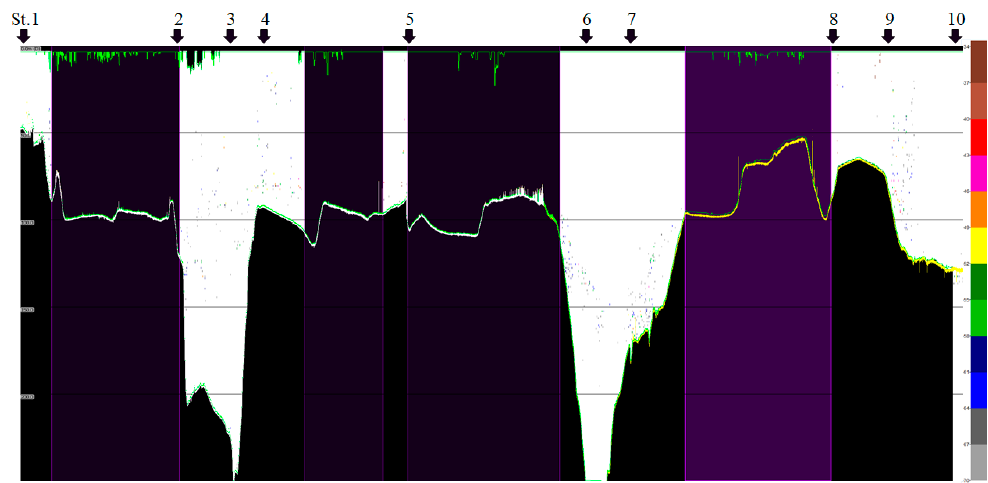
Figure 7. Vertical distribution of pacific cod.